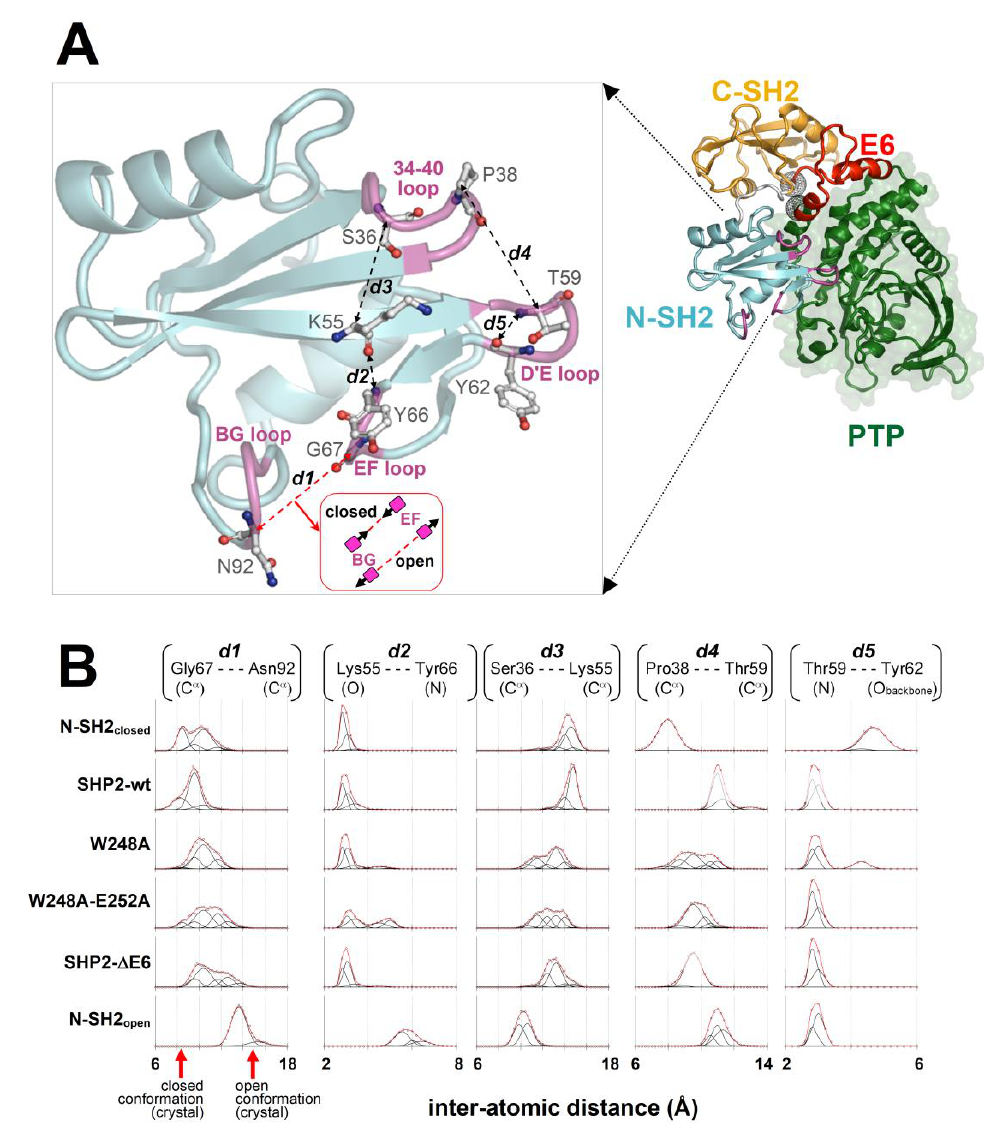
Figure 5. Conformational dynamics of key residues and loops of the N-SH2 domain. ( A ) Self-inhibited SHP2-wt structure (N-SH2 domain loops are colored in magenta, and the extremities of the E6 region are highlighted by the black spherical meshes centered at the C α atoms of Gln214 and Thr253). In the enlarged view, the interatomic distances (dashed lines) between pairs of N-SH2 atoms highlighting critical loop/loop or residue/loop separations (discussed in the text) are shown. ( B ) Plots of the fraction of MD conformers in function of the interatomic distances traced in the N-SH2 domain above (obtained with this domain in different structural contexts; see text and Table 1). Pro38(C α )-Thr59(C α ) indicates the separation of 34–40 and the D’E loop. Thr59(N)-Tyr62(O backbone ) distance is reported to infer potential backbone-backbone hydrogen bonding between these two residues in the D’E loop. Gly67(C α )-Asn92(C α ) represents the separation of the EF and BG loops, which determines the closed or open conformation (the arrows on the horizontal axis indicate the separations measured in the crystal structures of SHP2: closed conformation = PDB 2SHP; open conformation = PDB 1AYA). Lys55(O)-Tyr66(N) indicates the separation of Lys55 from the EF loop, also allowing one to infer potential backbone-backbone hydrogen bonding between the two residues. Ser36(C α )-Lys55(C α ) measures the separation of the 34–40 loop from Lys55. The points (open circles) in the plots were obtained by calculating the fraction of MD conformers (recorded every 5000 femtoseconds in the 3–30-ns interval of simulations) with interatomic distances falling within a 0.15-nm long sliding window. Deconvolutions of the plots with Gaussian functions (black lines) and their sums (red